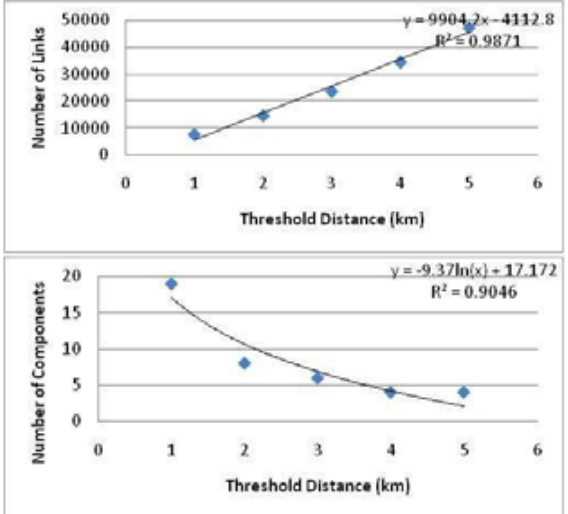
Figure 4: Impact of Threshold distance on the links and components